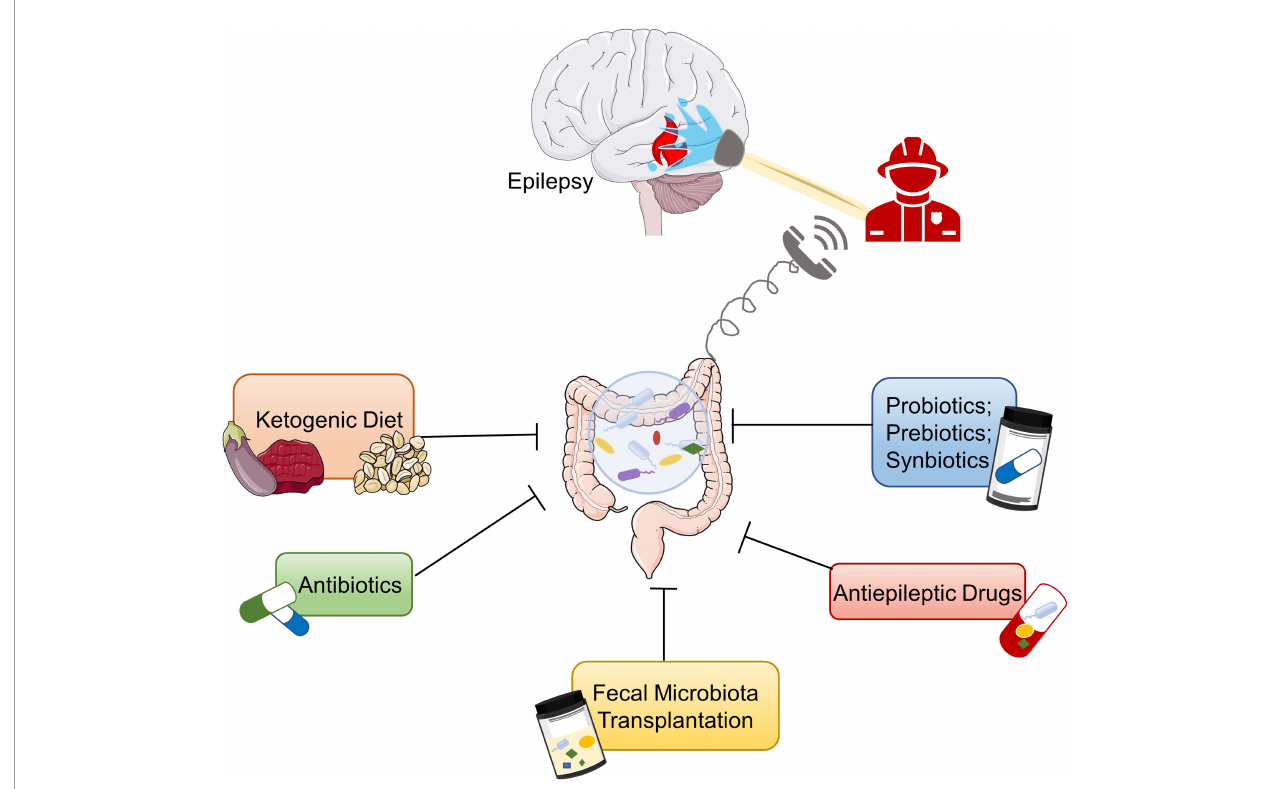
FIGURE 2 | Potential therapies for epilepsy based on gut microbiota. Ketogenic diet, antiepileptic drugs, probiotics, prebiotics, synbiotics, antibiotics, and fecal microbiota transplantation are potential treatments for epilepsy based on the microbiota – gut – brain